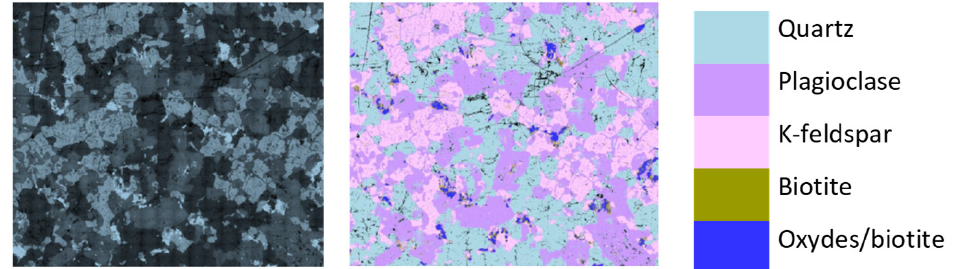
Figure A1. White granite: scattered electrons image (OIS Service Géoscientifiques Inc., Chicoutimi, QC, Canada).